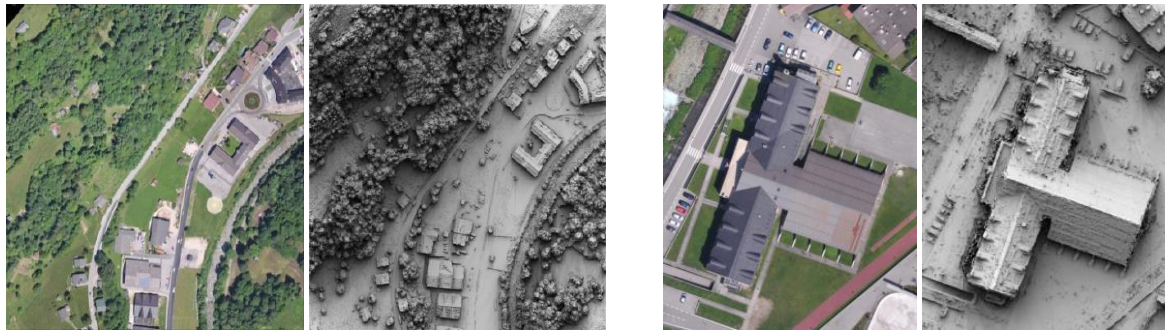
Figure 4: An example of the photogrammetric DSM (shaded view) over an alpine village (left) and a closer view of a building